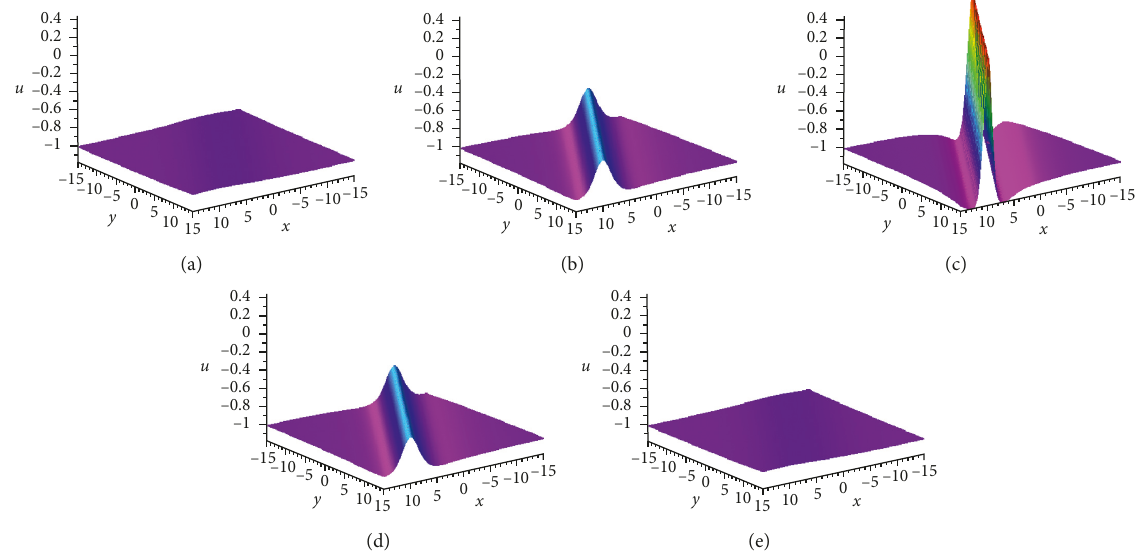
Figure 2: The propagations of line rogue wave (2) with (5) and (7) taking the parameters a and b 1 at different times (a) t (cid:28)